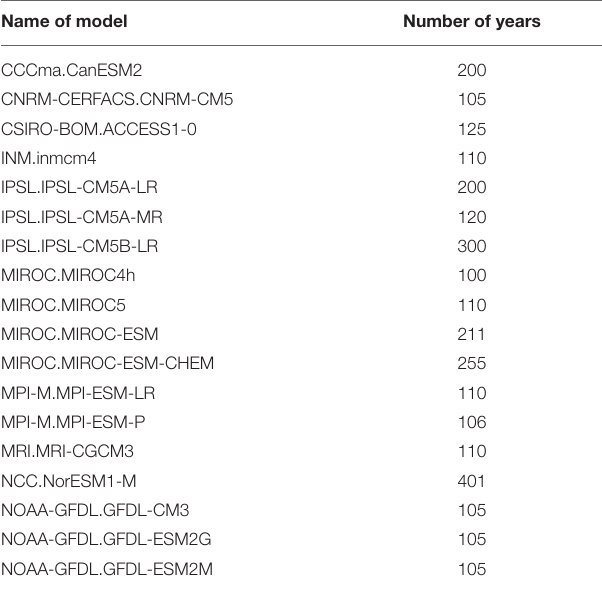
TABLE 1 | List of the CMIP5 models used and the corresponding length of the daily dataset, in years. Name of model Number of